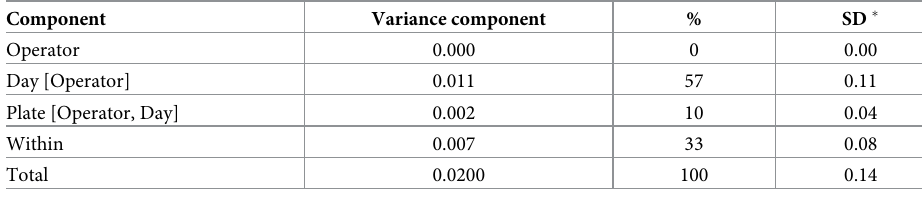
Table 4. Variance components of assay robustness assessment.